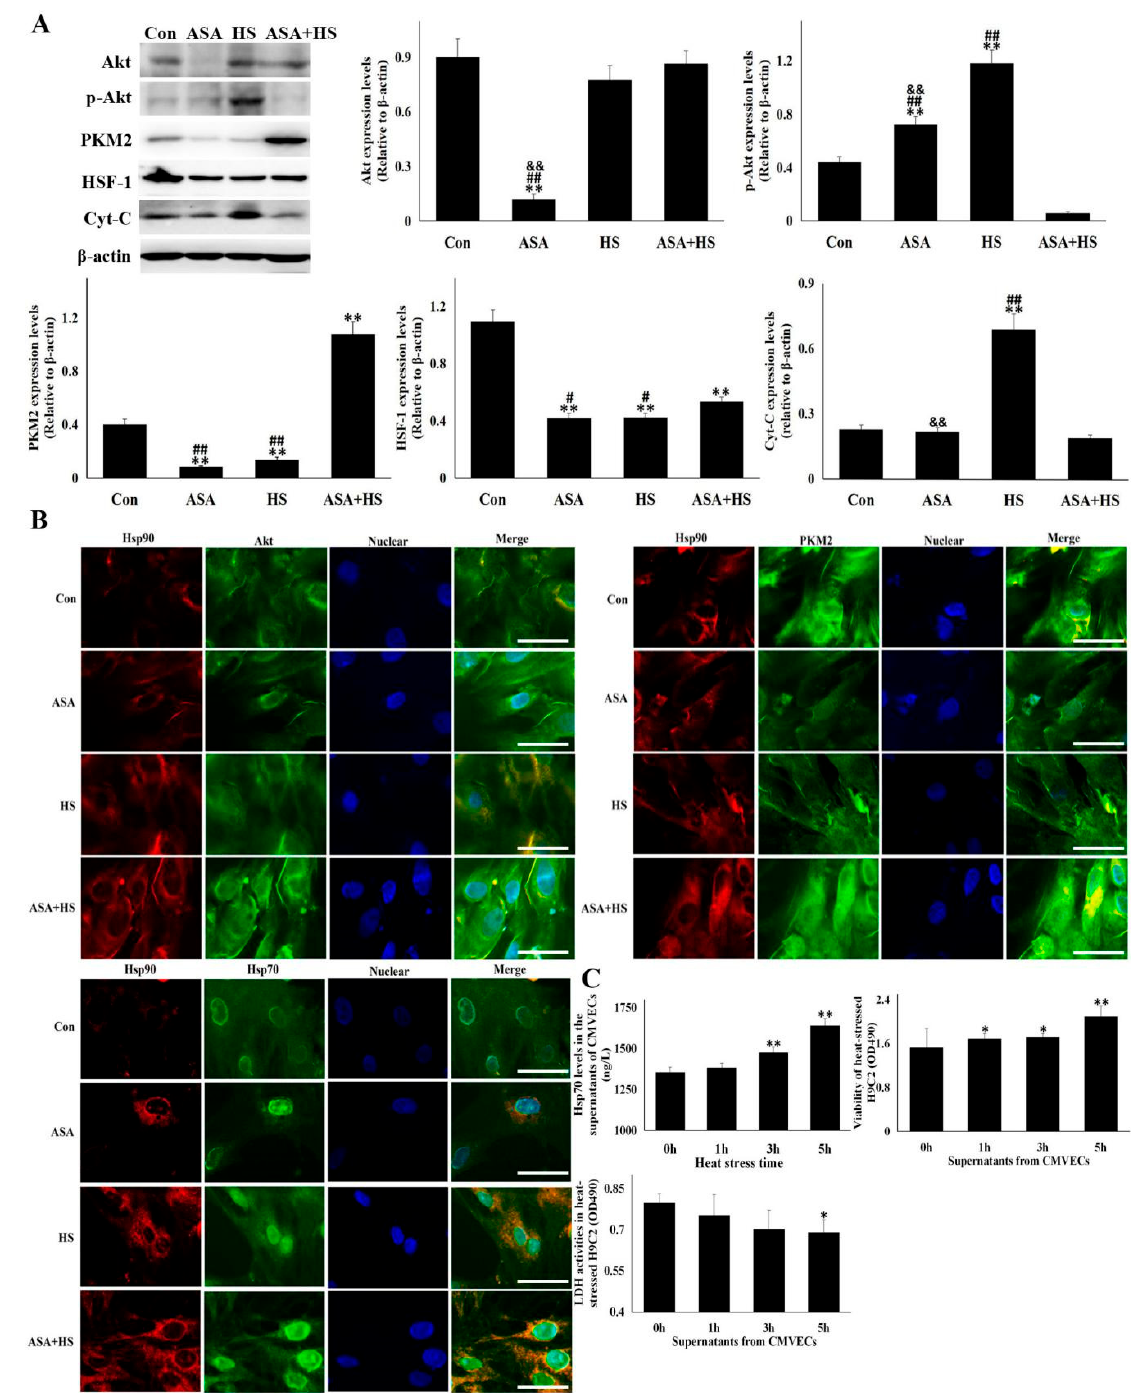
Figure 7. Akt and PKM2 signals and Hsp70 release from CMVECs were strengthened by Hsp90 induction. ( A–B ) CMVECs were treated with or without aspirin followed by heat stress for 5 h or not. Western blot analysis and immunocytochemistry were performed with the indicated antibodies. Data represent the means ± SD for three independent experiments. ( A ) Cellular total proteins were used for Western blot detection of the corresponding protein. The relative abundance of the tested proteins was normalized to that of β -actin. ( B ) Immunofluorescence was performed using anti-Hsp90 α , anti- Akt, anti-PKM2, and anti-Hsp70 antibodies. Representative images from Con, ASA, HS, and ASA + HS are presented (Hsp90: red fluorescence, Akt/PKM2/Hsp70: green fluorescence, nucleus: blue fluorescence, the merged signals of Hsp90 with Akt/PKM2/Hsp70 in the cytoplasm: yellow fluorescence). Bar = 20 µm. Con, cells without aspirin treatment and heat stress; ASA, cells treated with aspirin; HS, heat-stressed cells without aspirin treatment; ASA + HS, heat-stressed